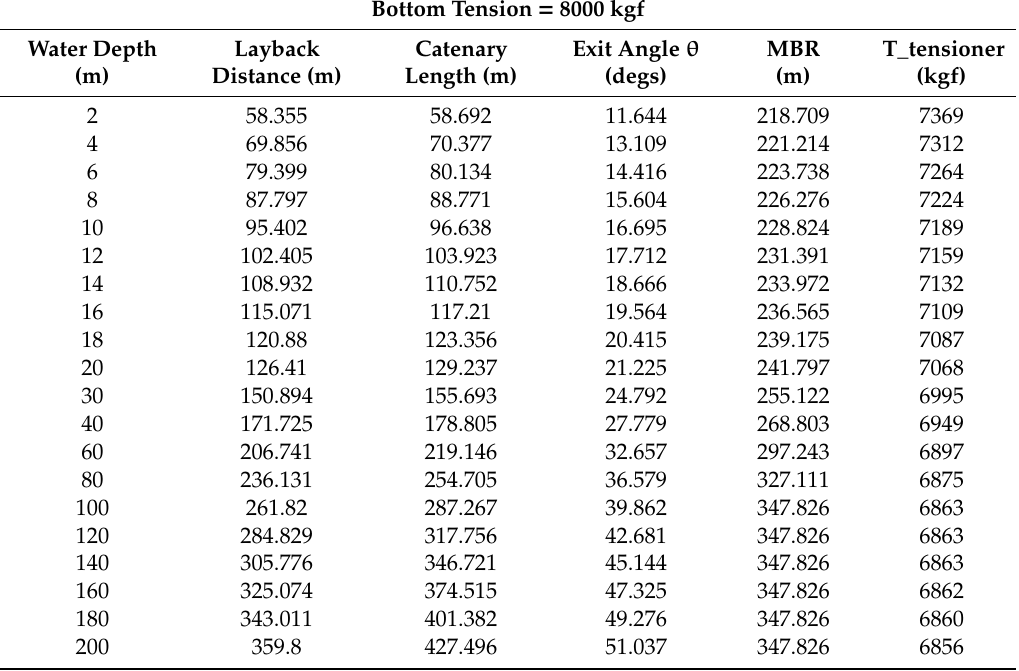
Table 3. Water depth and bottom tension combined e ff ects—Constant bottom tension at 8000 kgf VS Di ff erent water depth